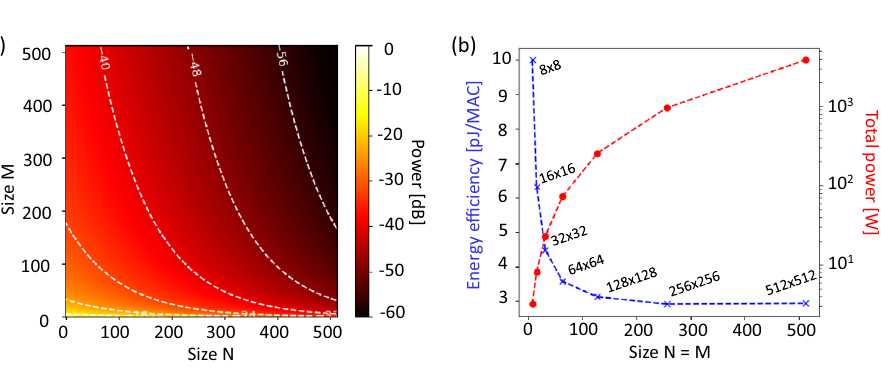
Figure 11. Schematic of the proposed IM-MRM-based N high-speed EAMs (or EOMs) are used for input data encoding.